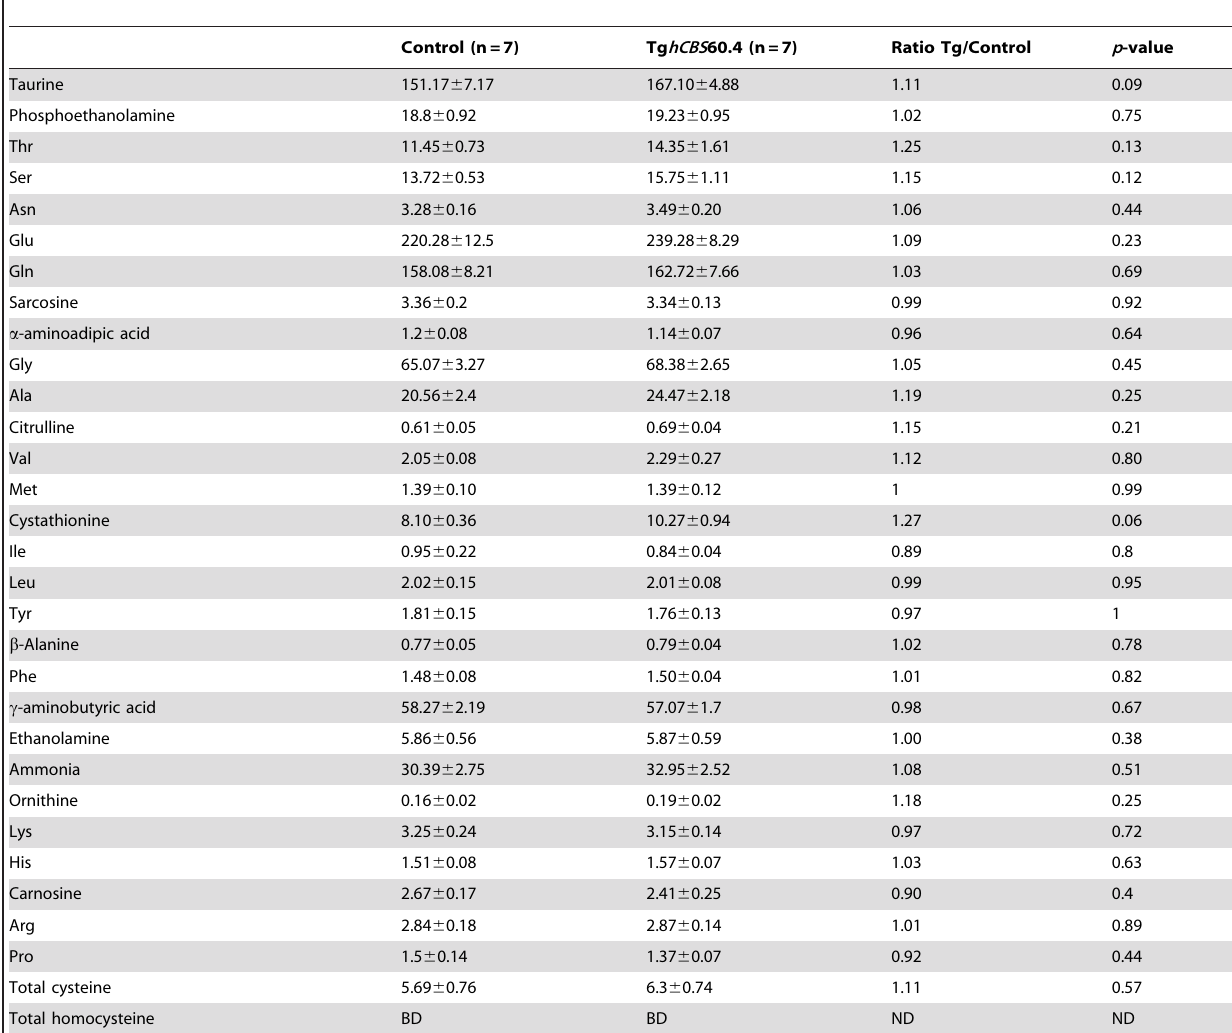
Table 1. Concentrations (nmoles/mg protein) of 30 amino acids and metabolite compounds in cerebellum extracts of Tg hCBS 60.4 and control